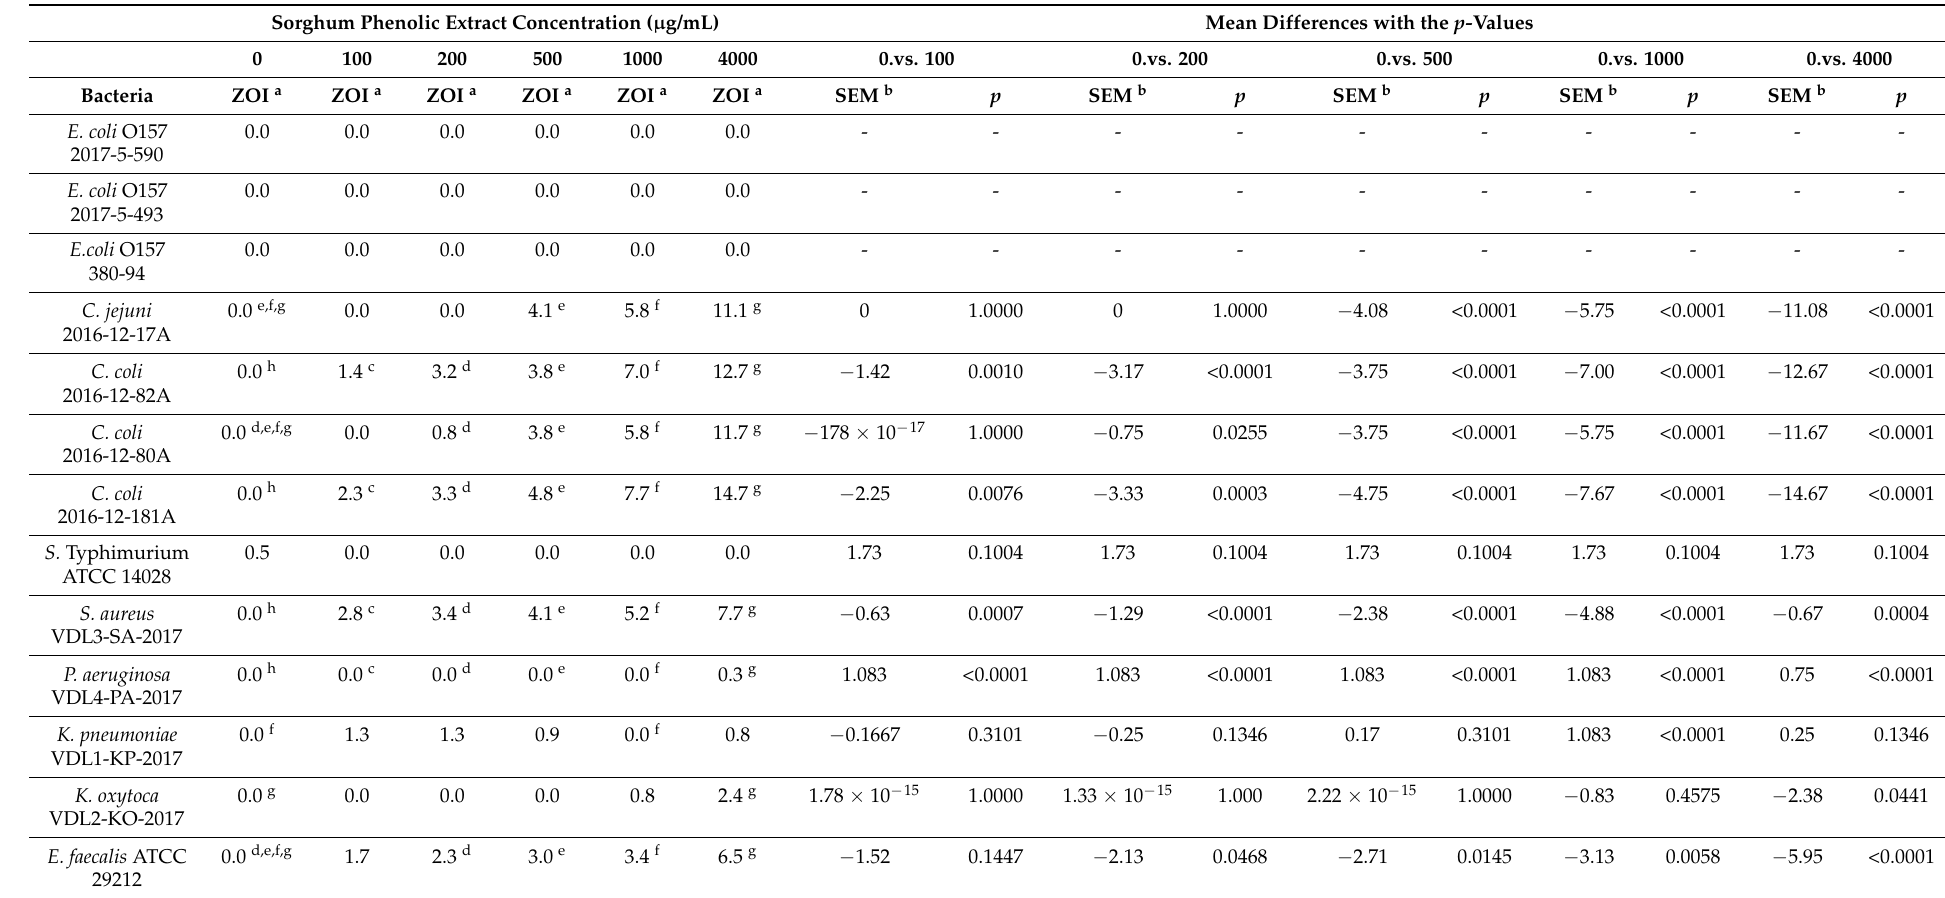
Table 3. Comparison of antimicrobial effects of different concentrations of sorghum phenolic extract vs.